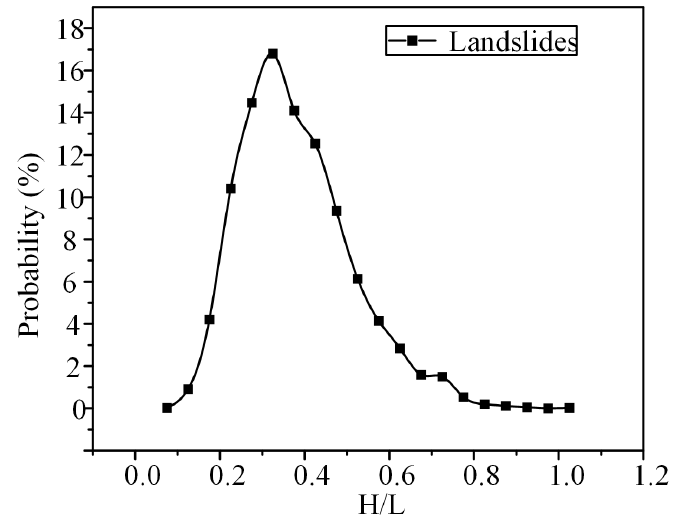
Figure 7. Probability distribution of H/L values.